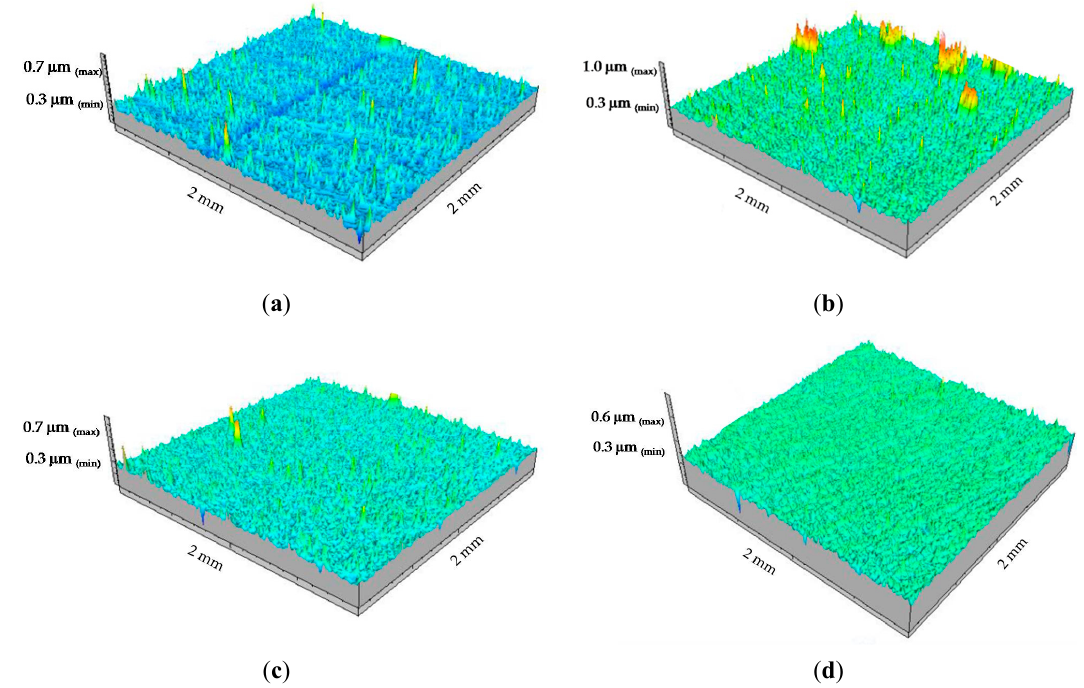
Figure 7. Microrelief of the surface of carbide end mills before and after applying various multi-component coatings (images obtained using an automated profilograph–profilometer): ( a ) uncoated; ( b ) TiN–Al/TiN; ( c ) TiN–AlTiN/SiN; ( d ) CrTiN–AlTiN–AlTiCrN/SiN.